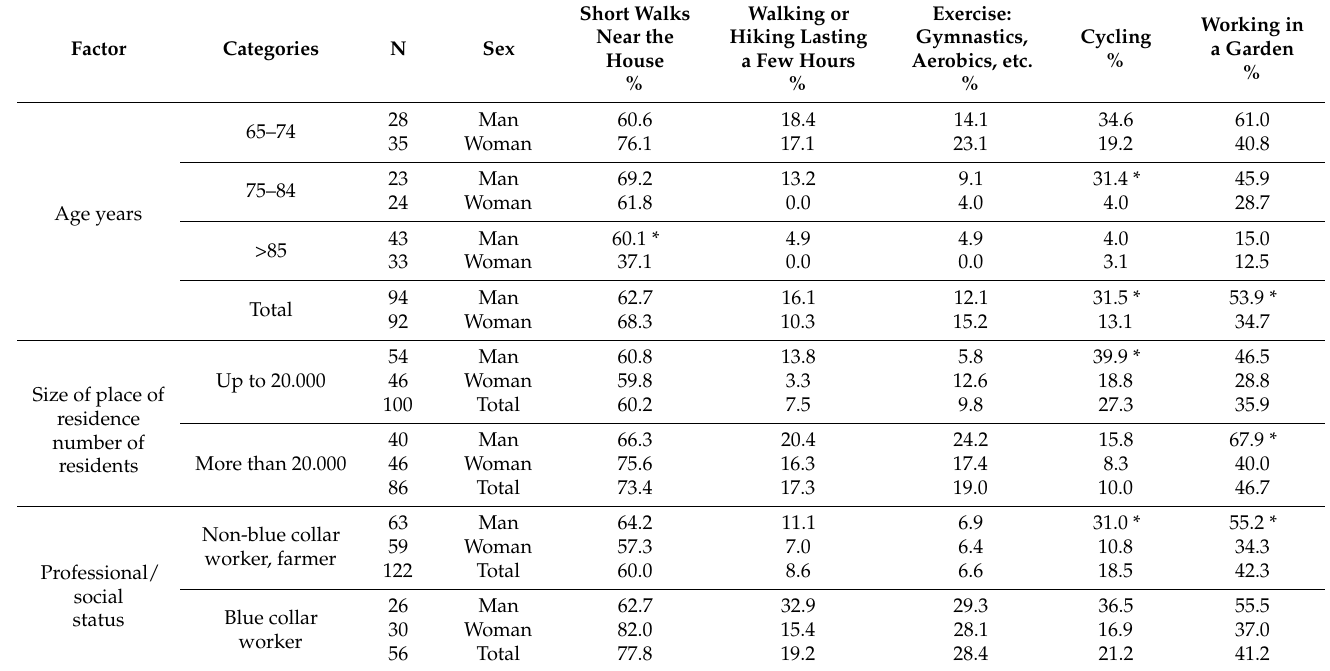
Table 1. Forms of Leisure Time Physical Activity (LTPA) undertaken by the respondents at least several times a week or more, according to age, sex, place of residence and socio-professional status in